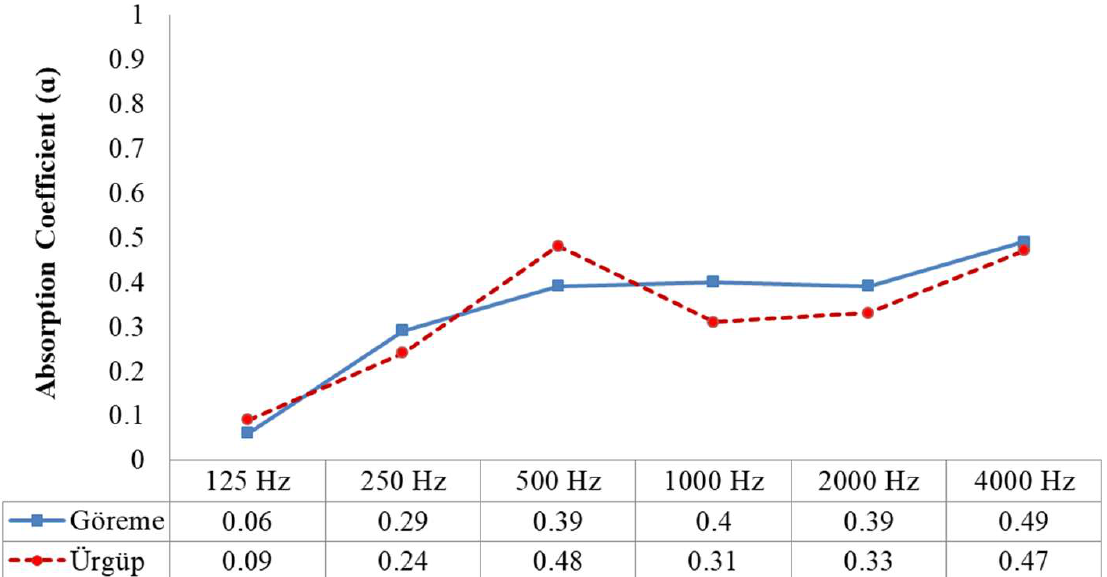
Figure 11. Absorption coefficient ( α ) values over 1/1 octave bands of the rocks from Göreme and Ürgüp. Maximum sound absorption (0.49) is achieved by the sample from Göreme at 4000 Hz.